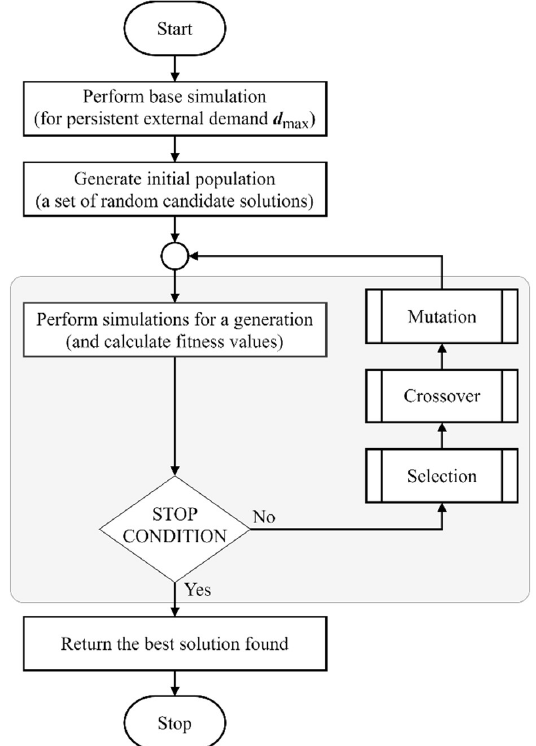
Figure 2. Genetic algorithm (GA) block diagram.